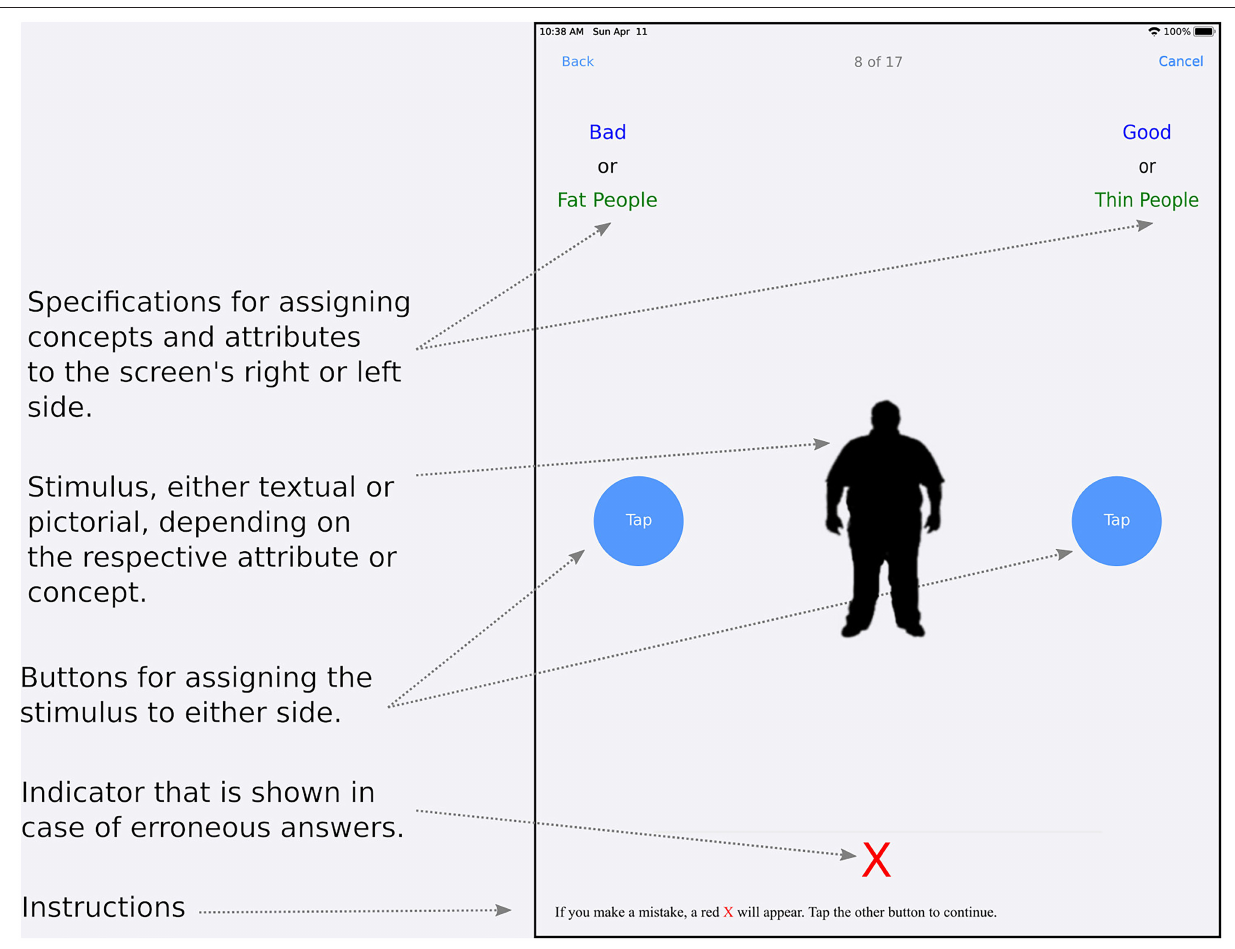
FIGURE 2 | Schematic for the basic layout of the IAT View for a ResearchKit-based